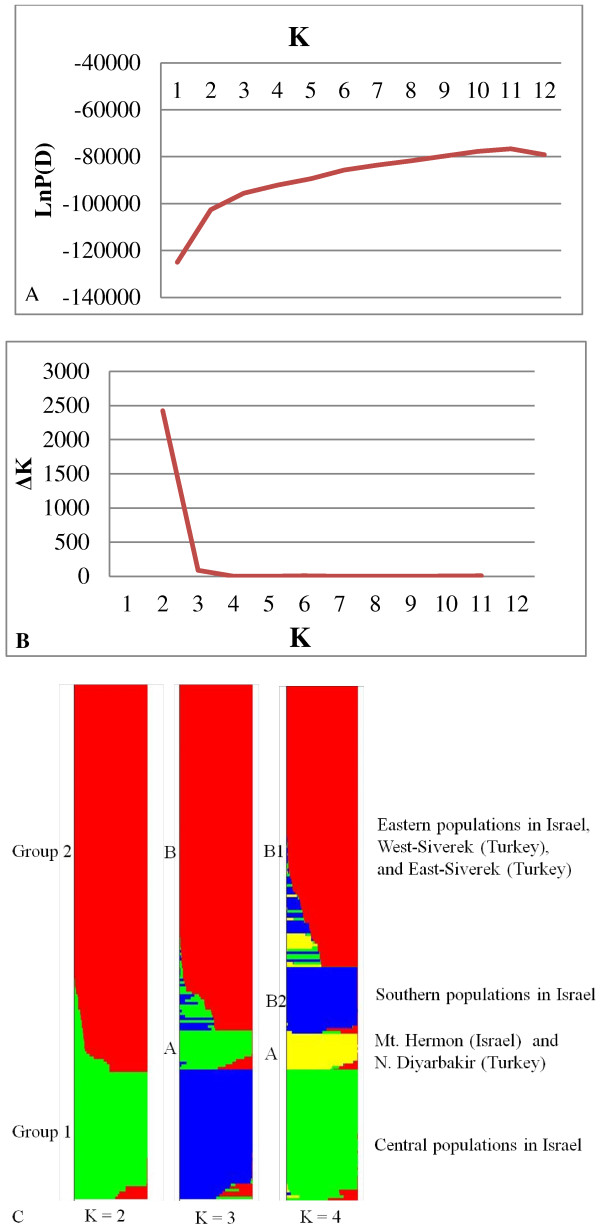
Genetic structure of 25 wild emmer wheat populations from Israel and Turkey. (A) Evolution of the natural logarithm probability of the data against K; (B) Magnitude of ΔK for each K value; (C) Clustering for K = 2 to 4 for the entire set of wild emmer wheat.